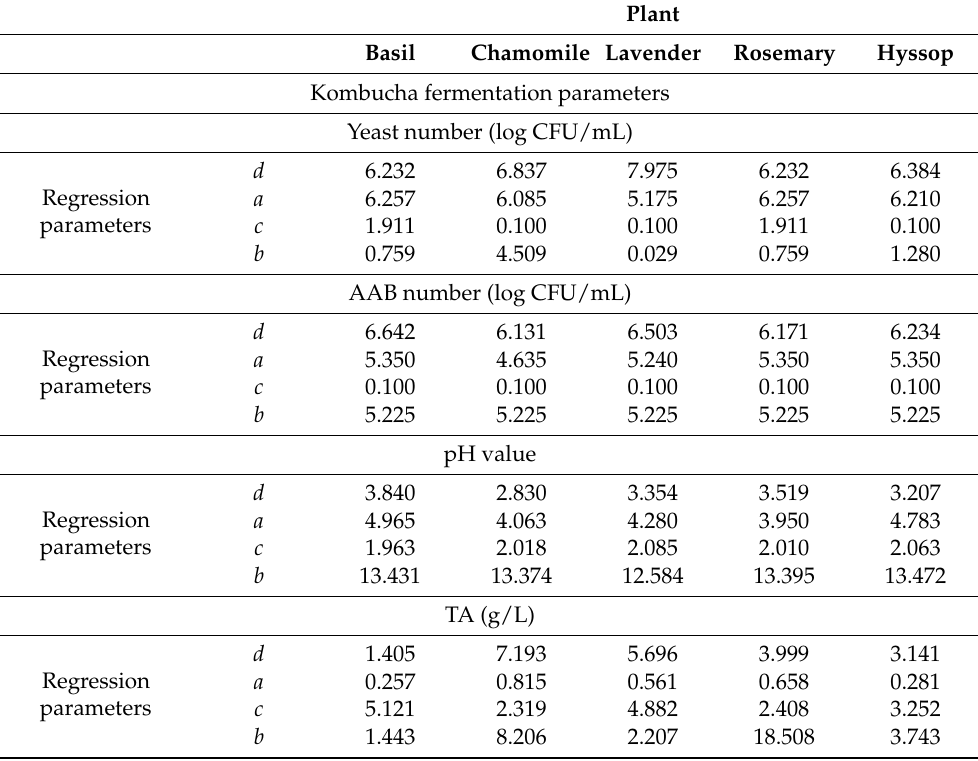
Table 1. Regression coefficients for kinetic models for kombucha fermentation based on Equation (4).